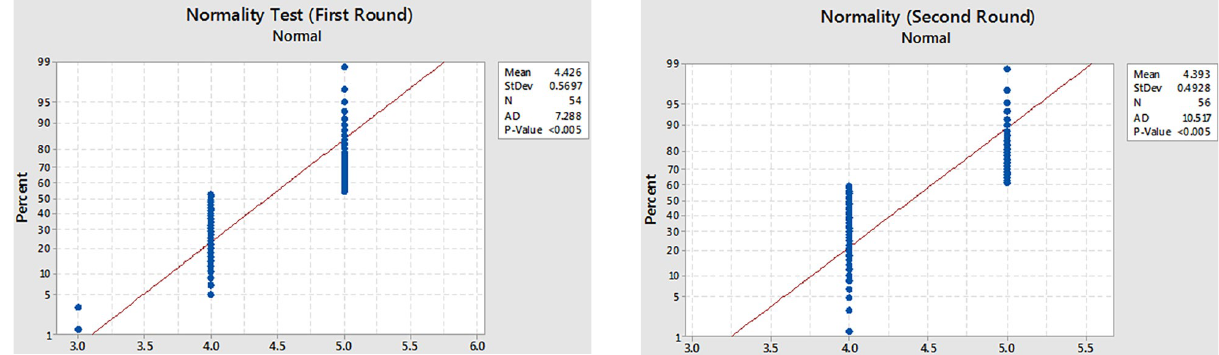
Figure 2. Normality test for the first and second rounds of the